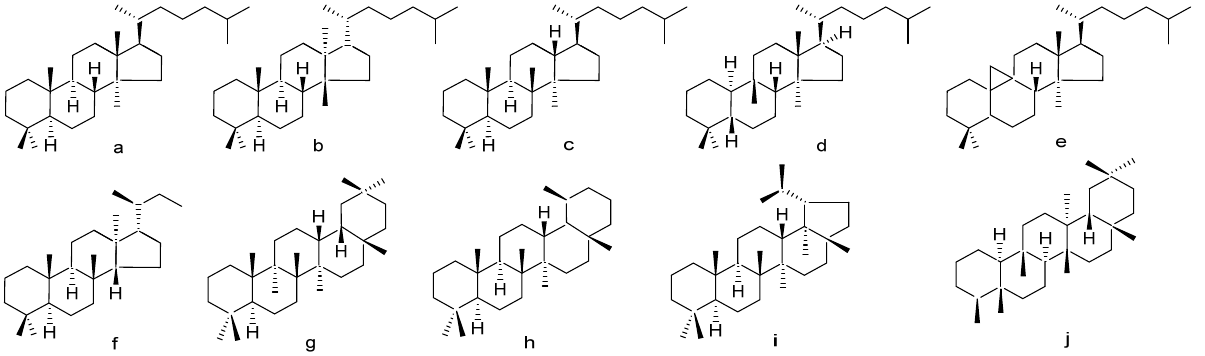
Figure 3. Chemical structures of four kinds of steroidal saponins, ( a ) deformed spirostanol types, ( b ) furostanol, ( c ) spirostanol, ( d ) isospirostanol. Table 1. Efficacy table of Chinese medicinal materials mainly containing saponins. No.